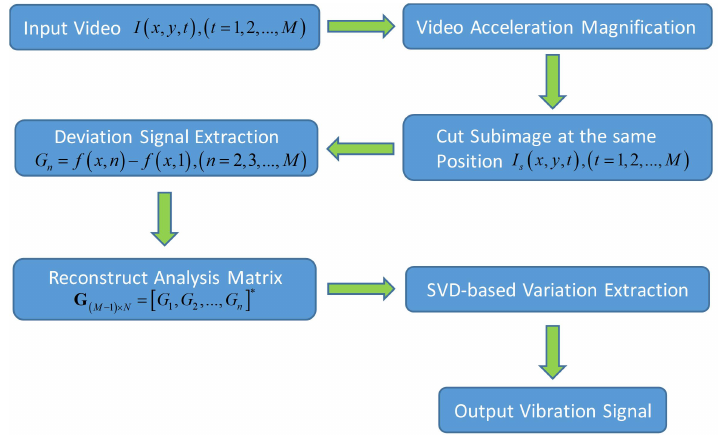
Figure 4. Flowchart of the low-level variation magnification and extraction